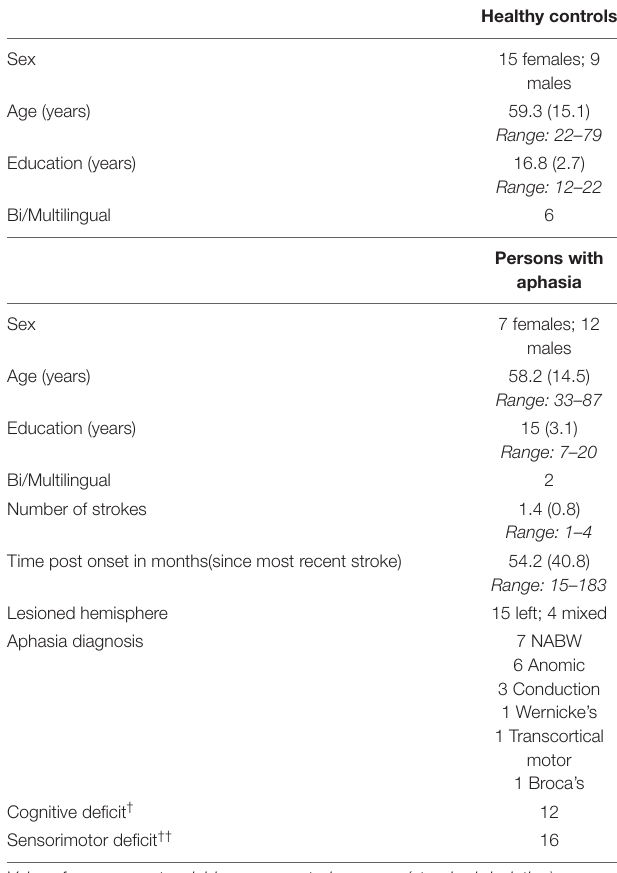
TABLE 1 | Demographics for neurologically healthy controls and persons with aphasia included in the analysis.